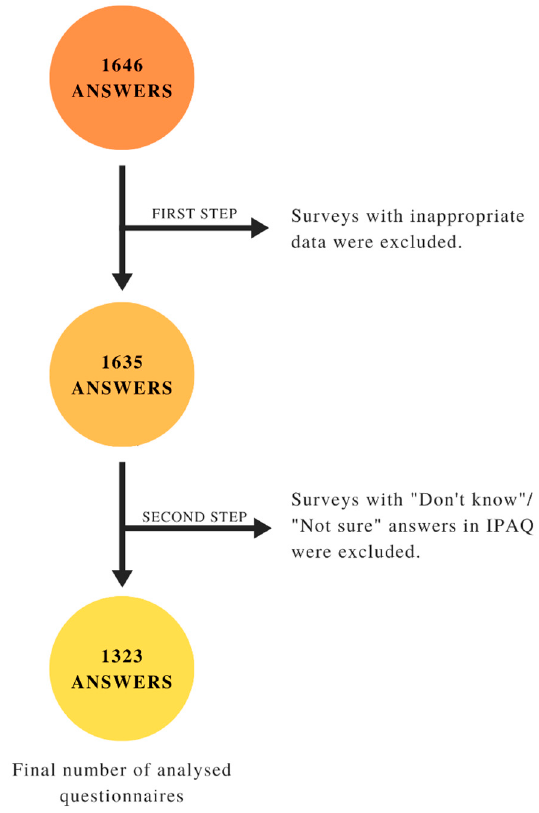
Figure 1. Stepwise data cleaning